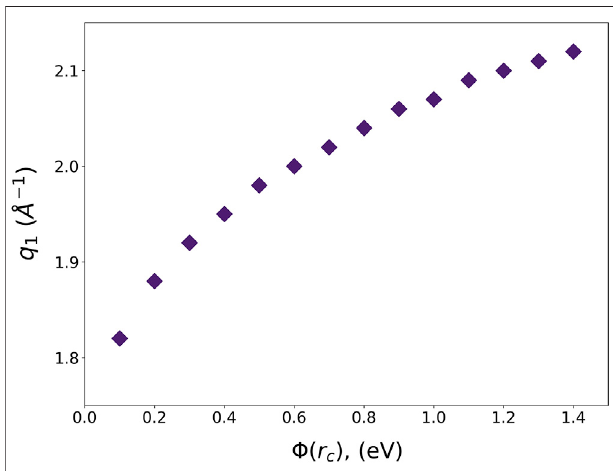
FIGURE 6 | The q 1 of liquid Argon pseudopotential as a function of the cut-off energy. Q 1 = 2.06 Å -1